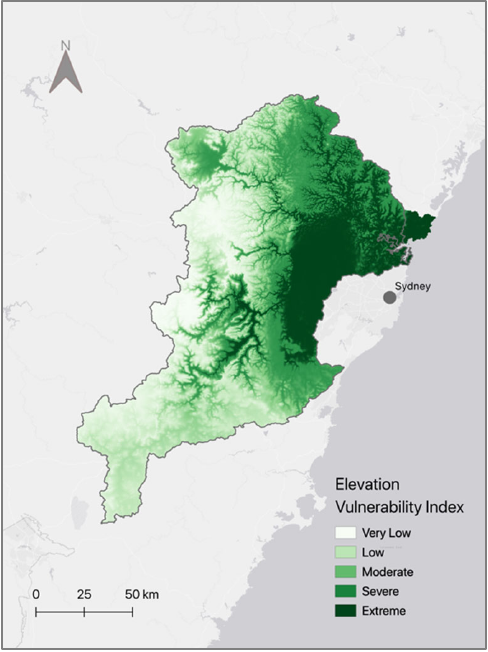
Figure 4. Map of elevation Vulnerability in the Hawkesbury-Nepean Catchment after standardising with Fuzzy membership. Lighter colours indicate very low and low Vulnerability, while darker colours represent severe and extreme Vulnerability in accordance with Table 4.